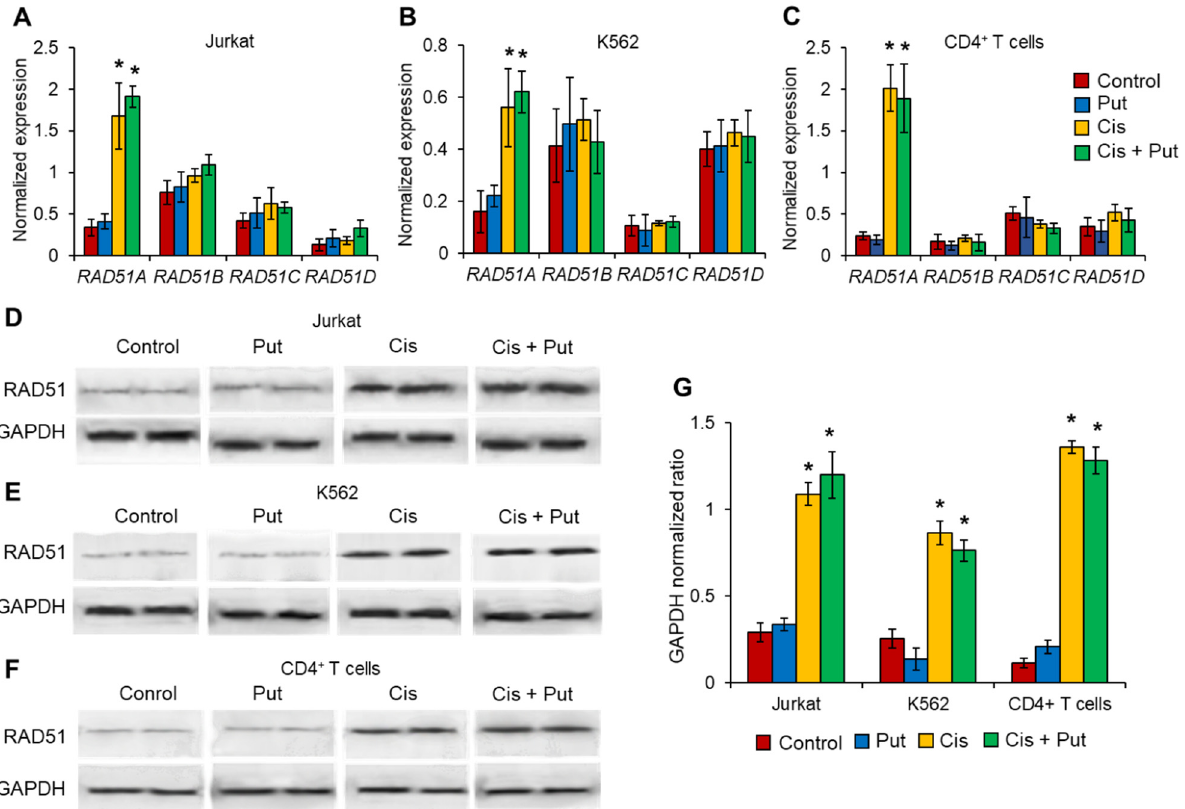
Figure 4. Induced RAD51A expression in cells treated with cisplatin (Cis). mRNA levels of RAD51 members measured by real-time RT-PCR in cancer cell lines ( A ) Jurkat, ( B ) K562, or ( C ) normal CD4 + T lymphocytes pretreated with putrescin (Put) and incubated with Cis. mRNA levels were normalized relative to the expression of the reference gene 18S . ( D , E , F ) Western blotting for RAD51 protein and the reference protein GAPDH in treated cells. ( G ) Results of RAD51 protein quantification relative to GAPDH. n = 4. * p ≤ 0.05 vs. control intact nontreated cells.